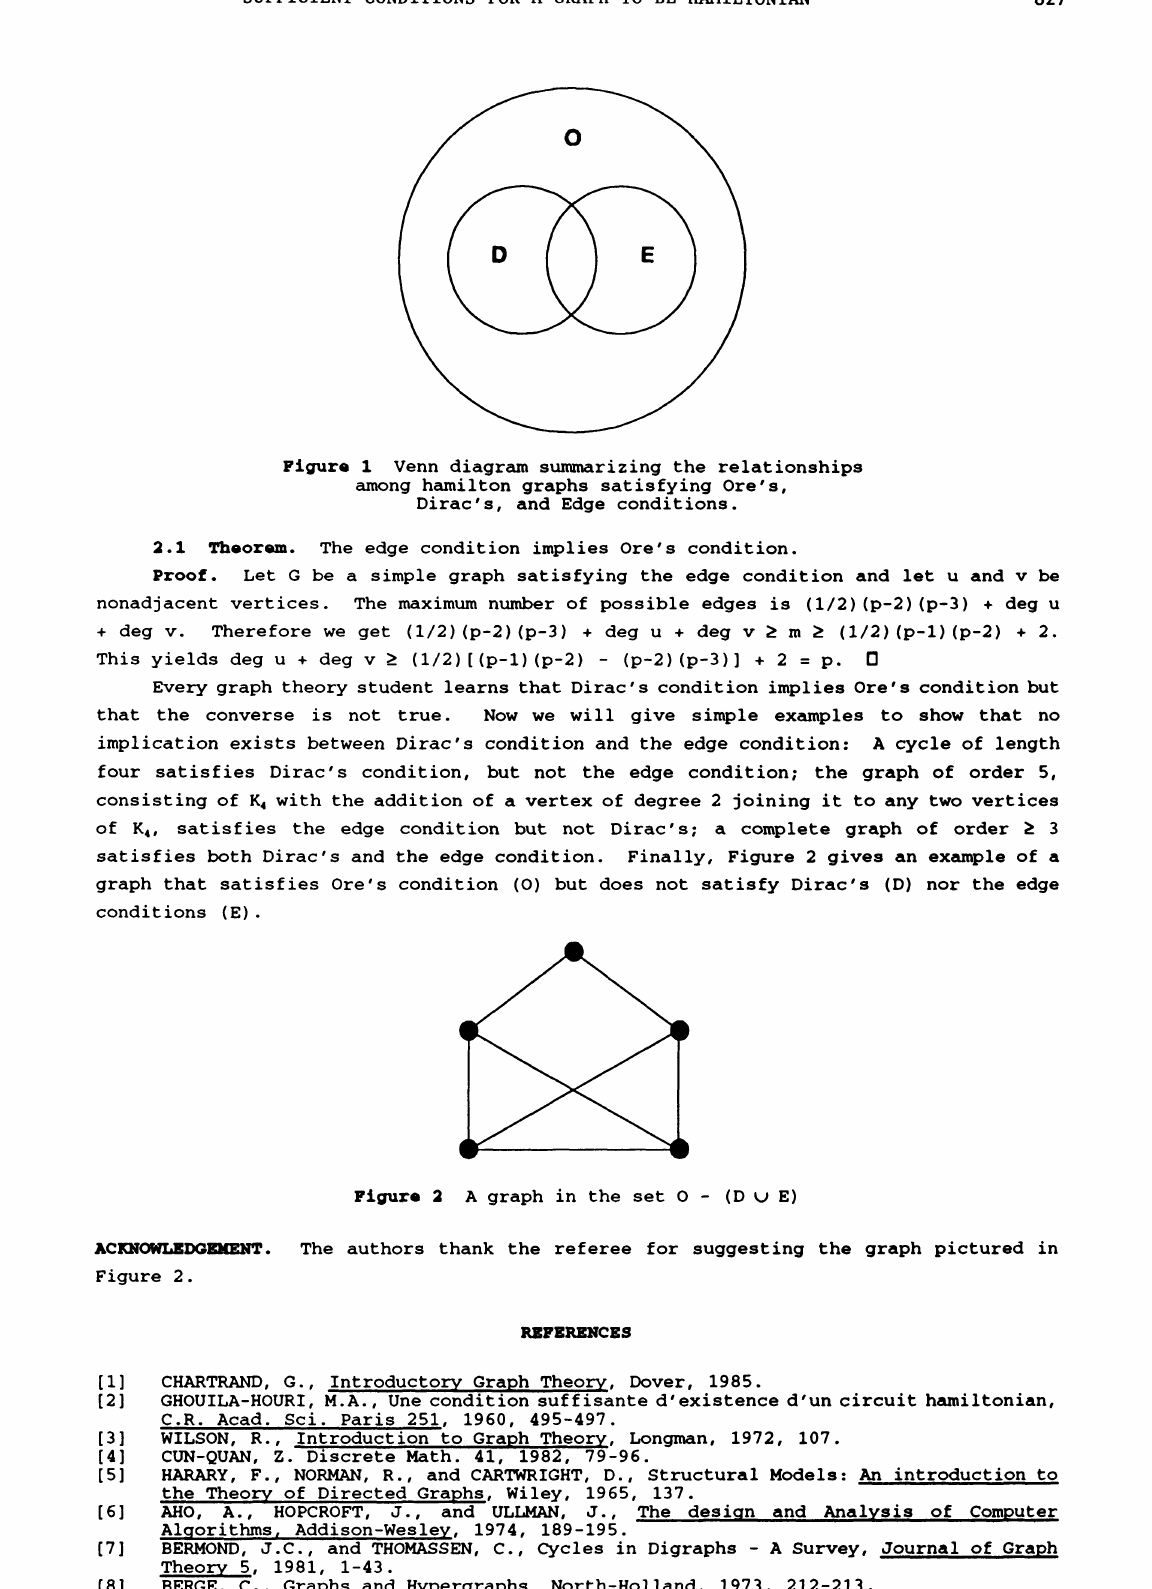
Figure 1 Venn diagram summarizing the relationships among hamilton graphs satisfying Ore’s, Dirac’s, and Edge conditions.